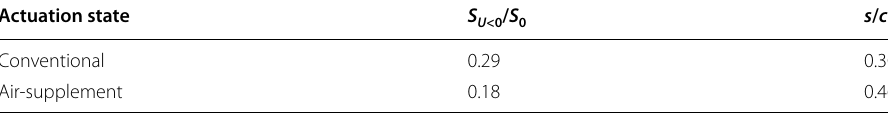
Table 2 Flow separation parameters under different actuation states